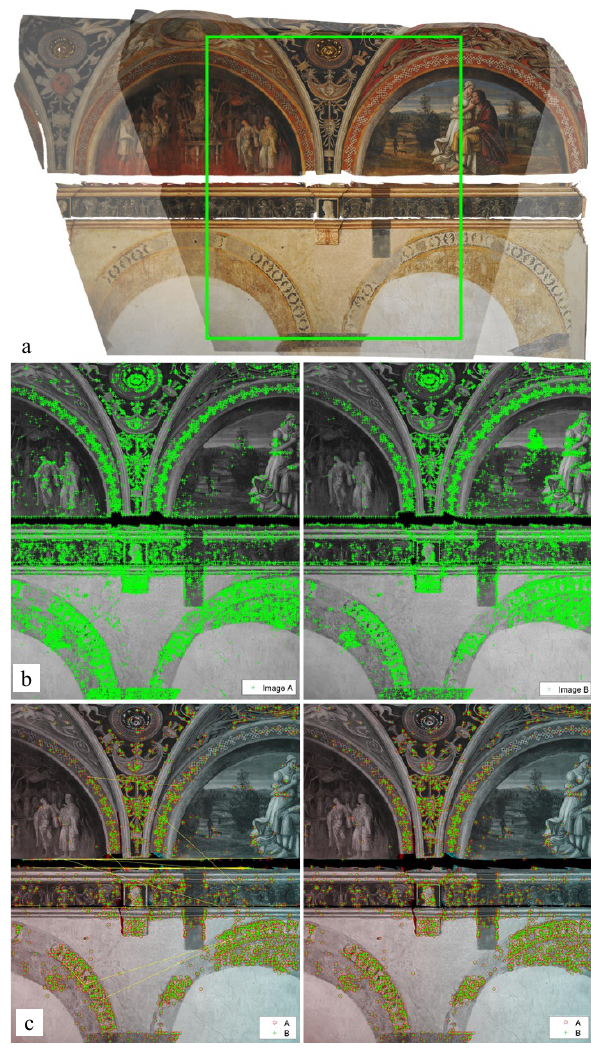
Figure 2 . Procedure for orthophoto comparison. a) Orthophotos overlapping and cropping. b) Feature extraction from the two images. c) Feature matching and removal of